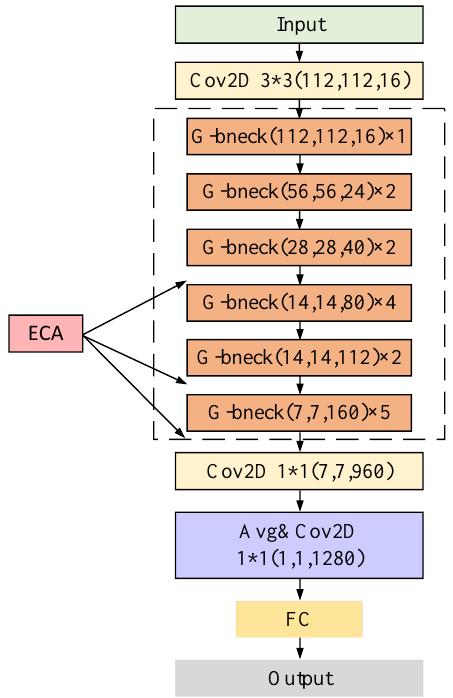
Figure 5. Improved feature extraction structure.